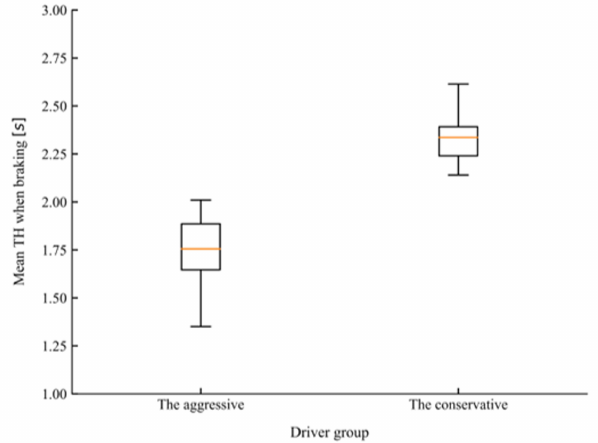
Figure 9. The comparison of mean time headway (TH) when braking for the two driving